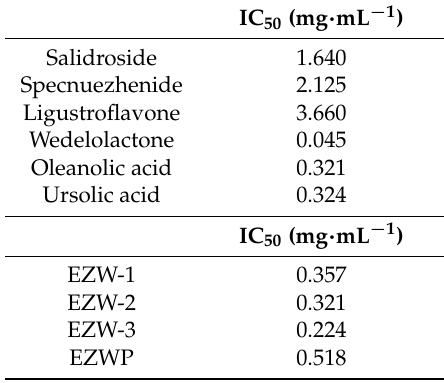
Table 3. Half maximal inhibitory concentrations (IC 50 ) of various standard stock and Erzhiwan (EZW) samples ( n = 3).